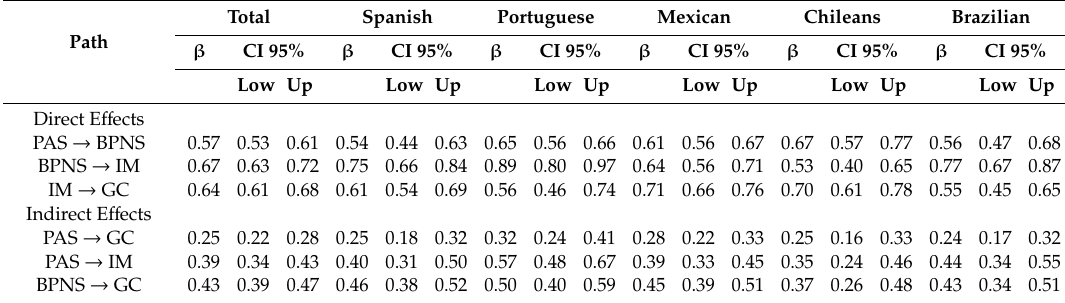
Table 4. Direct and indirect e ff ects in all